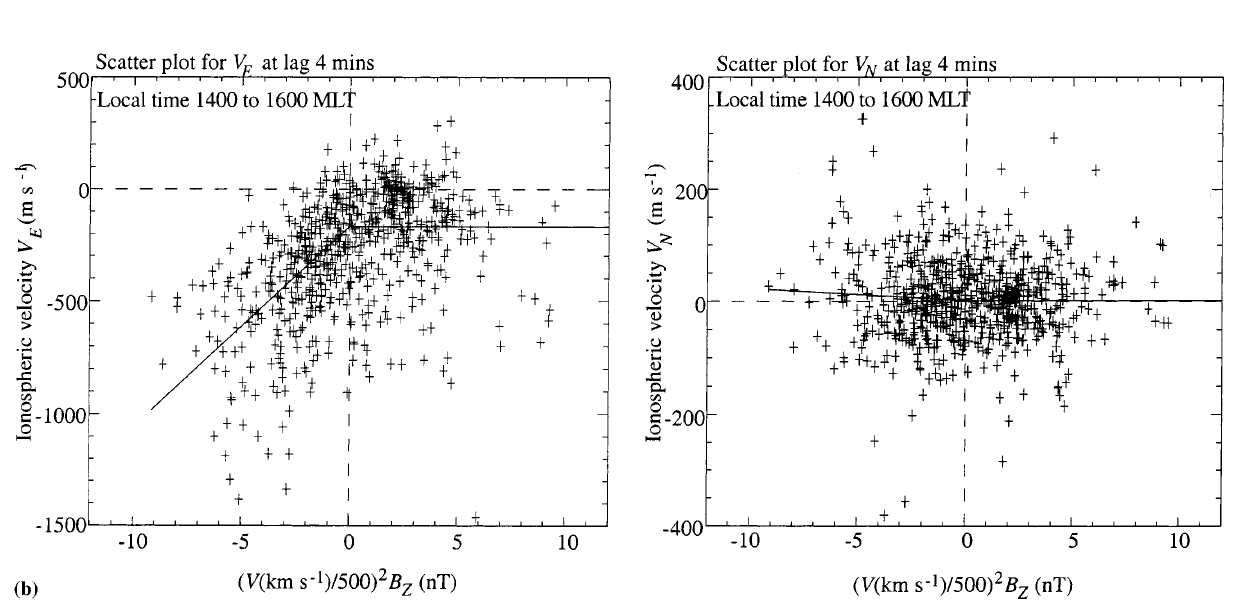
Fig. 4. b As for a except for the 2-h interval centred on